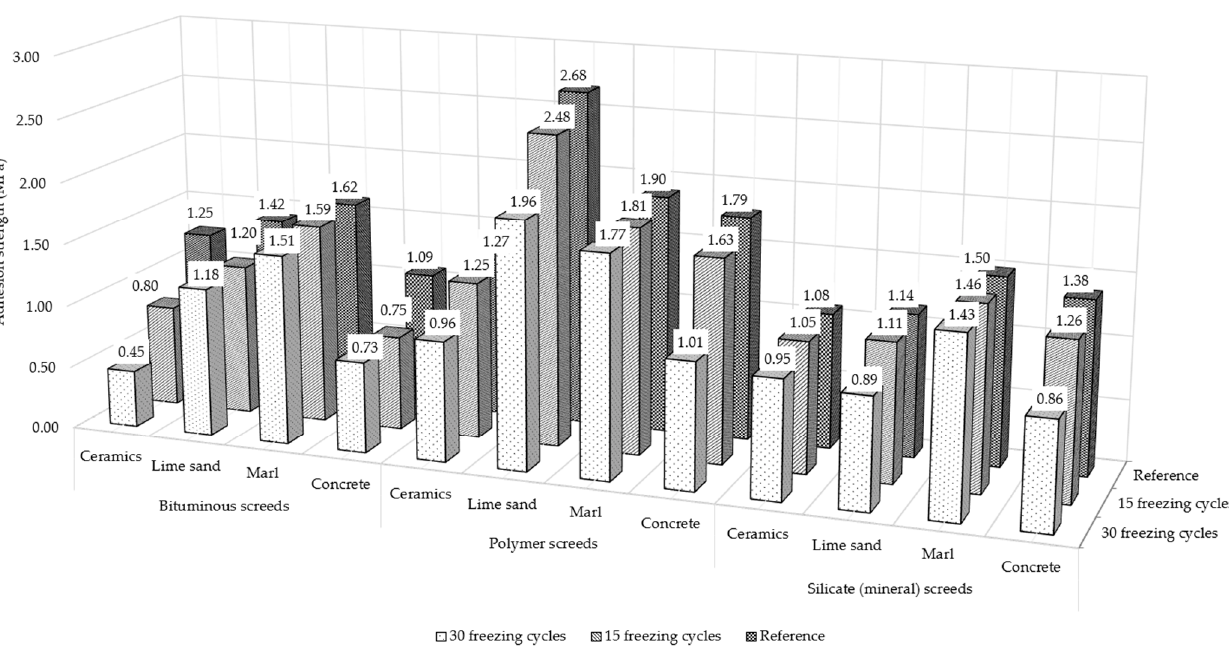
Figure 15. Results of the tear-off test, tensile strength.